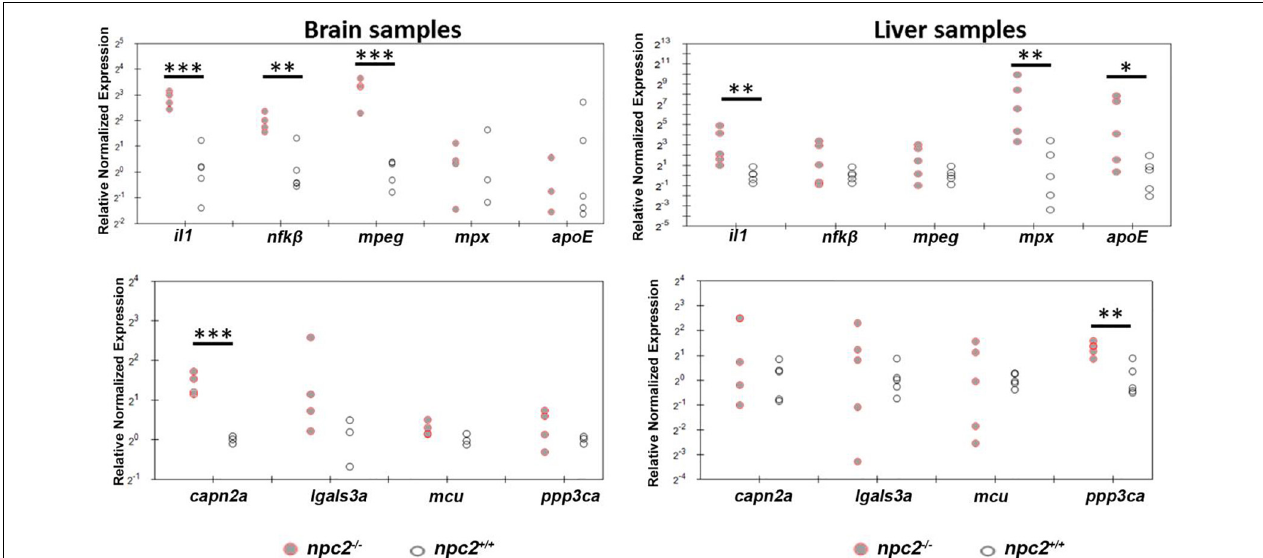
FIGURE 9 | Signs of inflammation and alterations of Ca 2 + homeostasis in npc2 − / − zebrafish. Scatterplots show the normalized expression of selected genes in brain and liver tissue from 9-month-old npc2 − / − homozygotes and wildtype zebrafish. Each circle corresponds to one zebrafish. The 18 S ribosomal gene was used as a reference. Samples from at least three fish were analyzed. *** p < 0.001, ** p < 0.01, and * p <